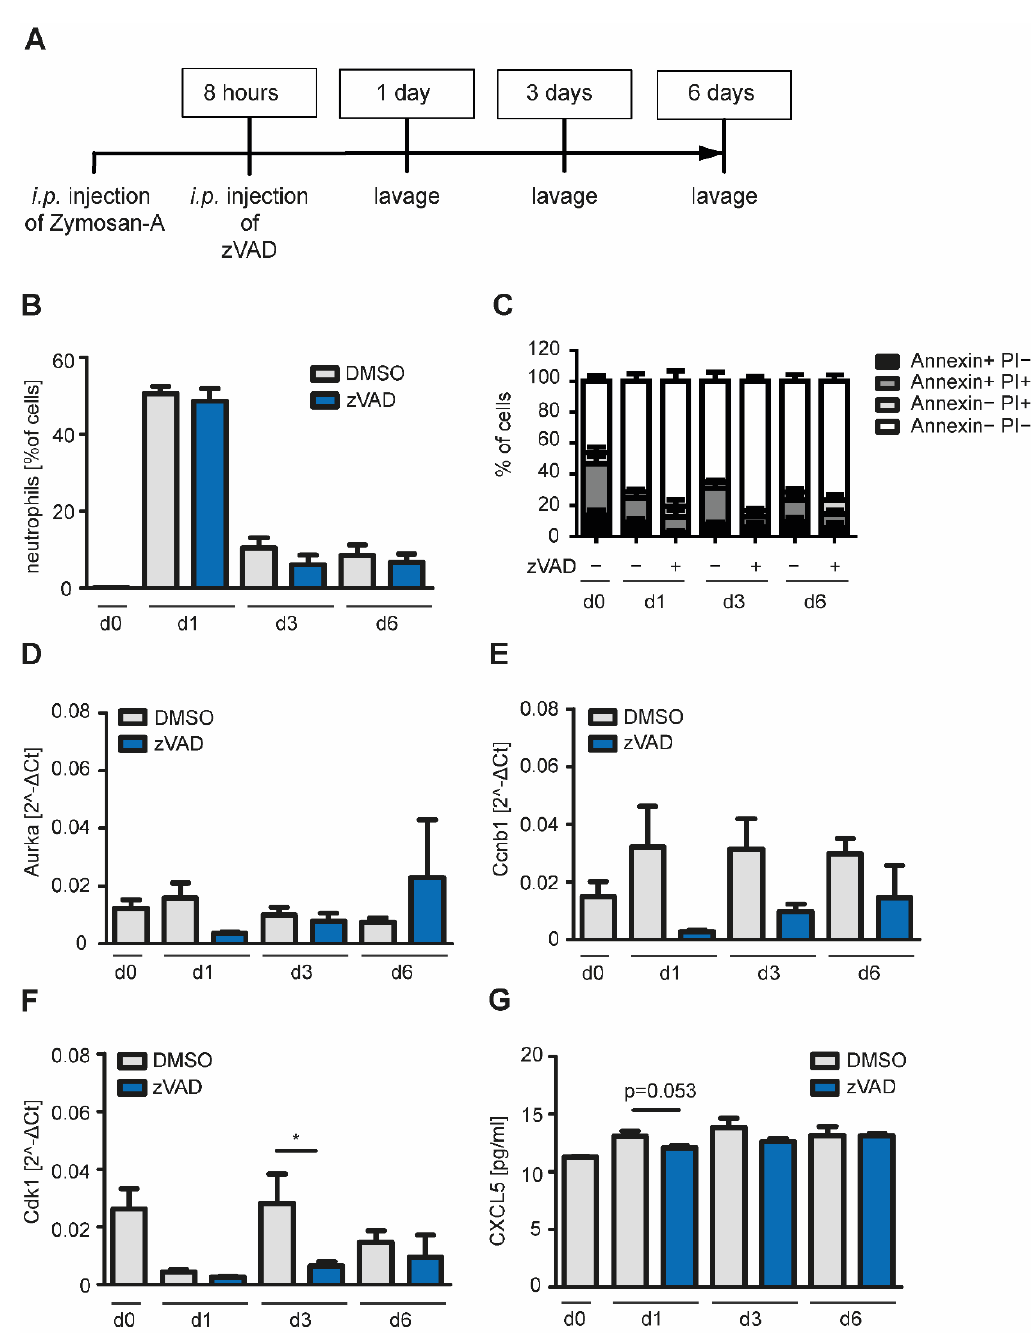
Figure 6. Inhibition of apoptosis in a model of Zymosan-induced peritonitis in mice. ( A ) Zymosan-A was injected i.p. into mice to induce self-resolving peritonitis. After 8 h, pan-Caspase inhibitor zVAD.FMK was injected i.p. to inhibit apoptosis. At day one, three or six after Zymosan-A injection cells of the peritoneum were harvested by lavage with 3 mL PBS. ( B ) Neutrophils were defined as CD45 + Ly-6G + Ly-6C + MHC-II - and percentage of neutrophils in the lavage was determined by flow cytometry ( n = 3–9). ( C ) Cells of the lavage were stained with Annexin V/PI and analyzed using flow cytometry ( n = 5–10). ( D – F ) Cells of the lavage were seeded and adherent macrophages were selected by washing with PBS. RNA of macrophages was isolated and levels of Aurka, Ccnb1 and Cdk1 were quantified using RT-PCR ( n = 3–6). ( G ) Concentration of CXCL5 in the lavage was measured using Legendplex assay and flow cytometry ( n = 4–9). Mean ± SEM are shown; * p < 0.05.